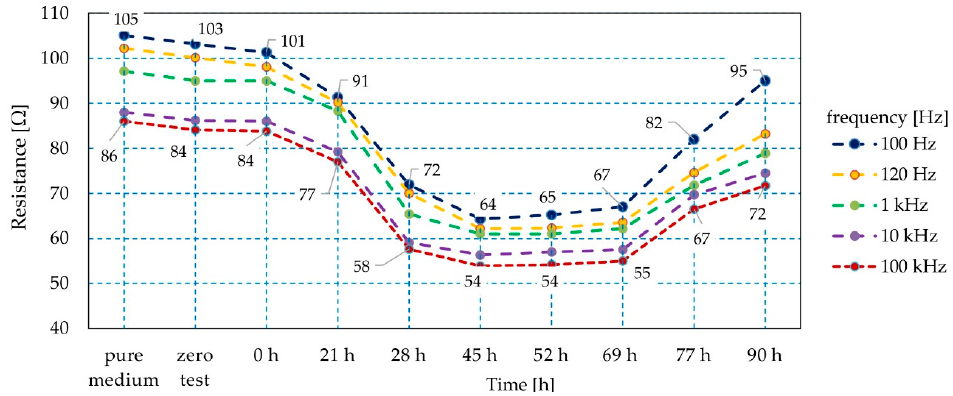
Figure 9. The resistance characteristics of the textile sensor during bacterial colony